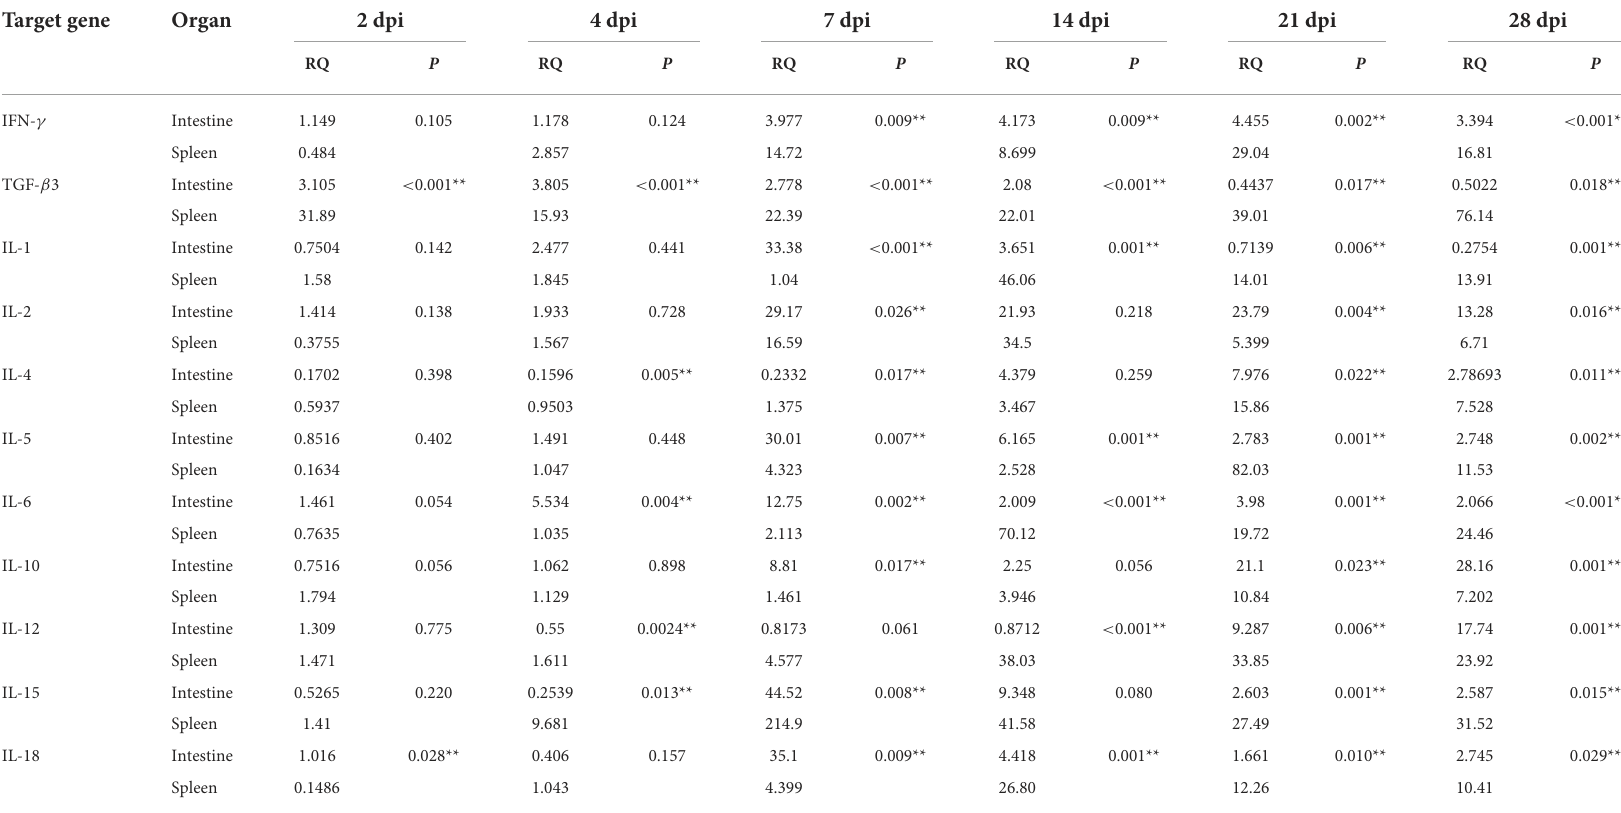
TABLE 8 Comparison of relative cytokine gene expression in the intestine and spleen of Prohemistomum vivax- experimentally infected pigeons. Target